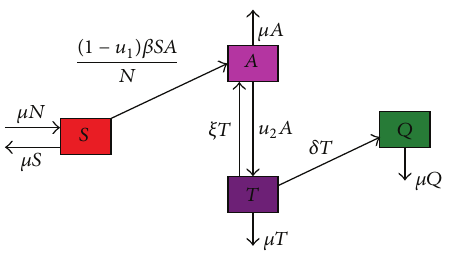
Figure 1: Transfer diagram for the dynamics of alcoholism